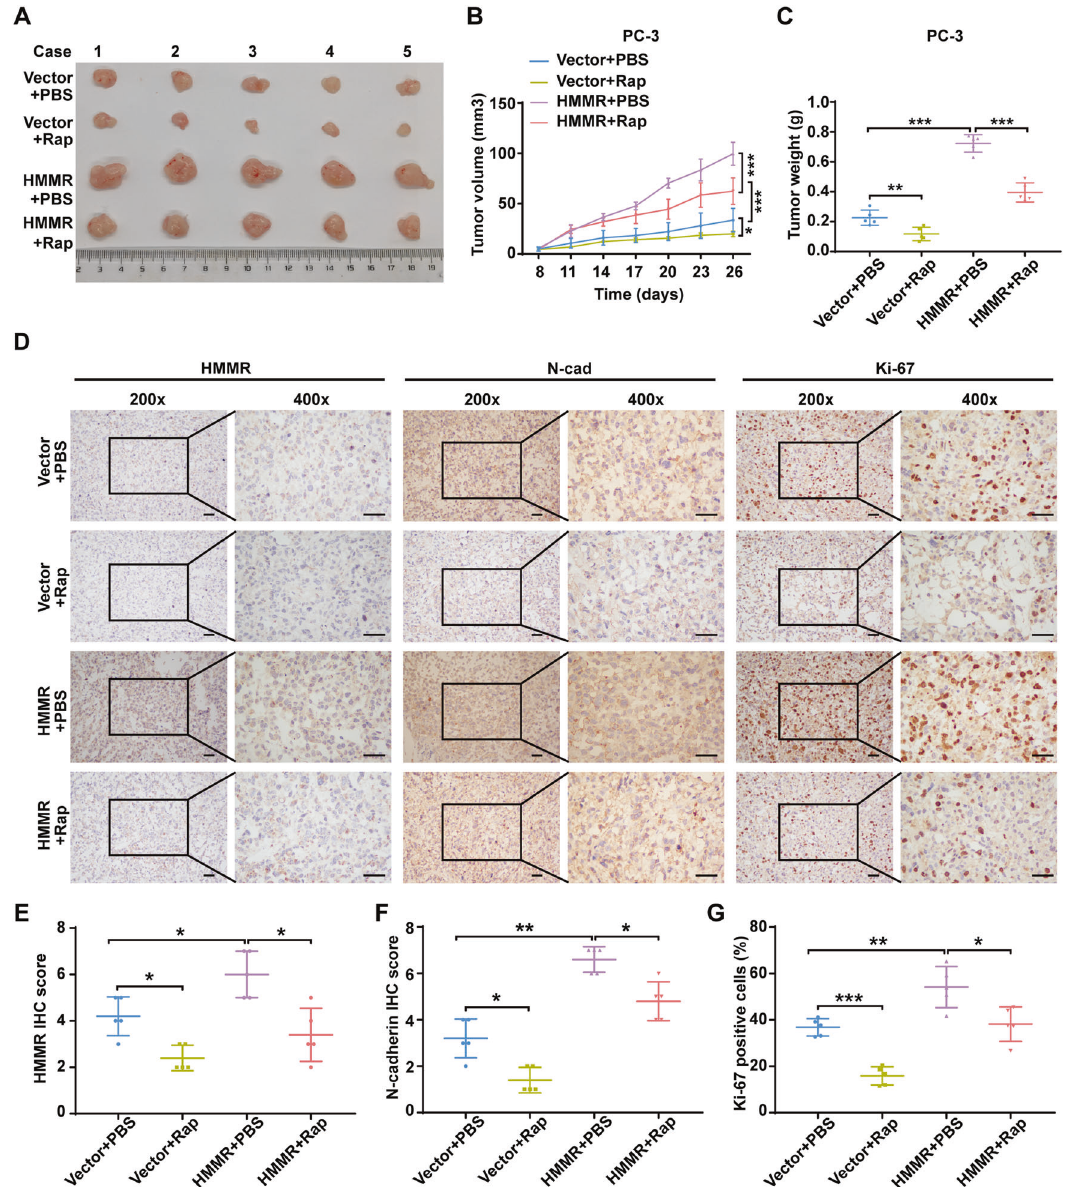
Fig. 7 mTOR inhibitor partly abolished the oncogenic role of HMMR. A Gross observation of subcutaneous tumours in the vector and HMMR overexpression groups treated with/without rapamycin. B Analysis of tumour volumes of the indicated subcutaneous tumours recorded every three days. C Analysis of tumour weight of the indicated subcutaneous tumours. D Representative images of HMMR, N- cadherin, and Ki-67 of the indicated subcutaneous tumours; scale bar: 100 μ m. E – G Quanti fi cation of HMMR ( E ), N-cadherin ( F ) expression, and proliferation index ( G ) in the indicated xenograft tumours, scale bar:100 μ m. Data were presented as mean ± SD. * p < 0.05, ** p < 0.01, *** p < nude male mice were randomly divided into two or four groups ( fi ve mice peer group). Double-blind was done. PCa cells (3 × 10 6 /100 µl) with stable HMMR silencing or the negative control were prepared with 1× PBS and mixed with Matrigel (BD Biosciences) in equal volumes, and then the cell mixture was subcutaneously injected into Balb/c nude mice. The growth state of the mice, as well as the tumour volumes, were recorded every 3 days. After 26 days of observation, all the mice were sacri fi ced for isolating tumour specimens for analysis. For rapamycin treatment, PCa cells with stable HMMR overexpression or empty vector were constructed and used as described above. After 7 days of injection, sterile 1× PBS or rapamycin (10 mg/kg) was injected into the mice every 3 days. After 26 days of observation, all the mice were sacri fi ced, and the volume and weight of specimens were recorded and analysed.